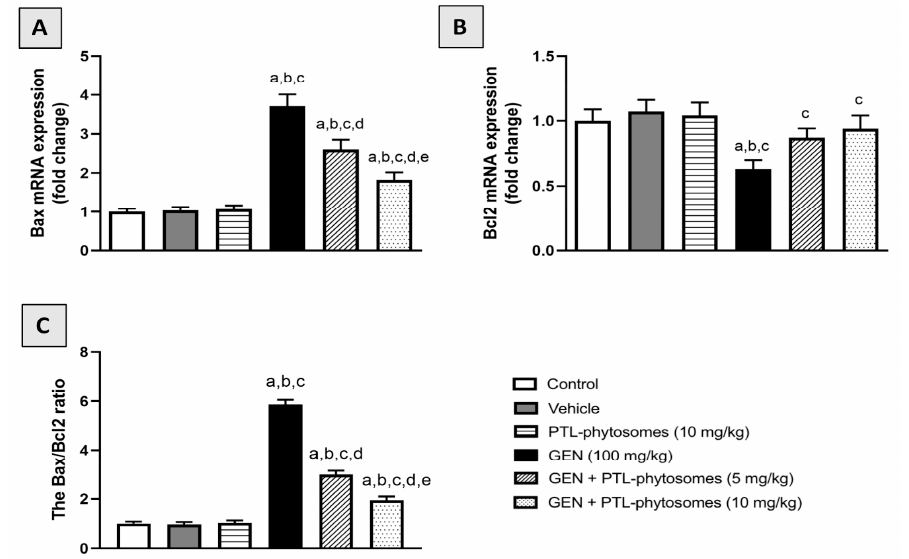
Figure 10. PTL-phytosomes regulated the expression of ( A ) Bax and ( B ) Bcl-2 ( C ) The Bax/Bcl-2 ratio in GEN-induced apoptosis. Data are expressed as Mean ± SD ( n = 6). a: significant when compared to control at p < 0.05; b: significant when compared to vehicle at p < 0.05; c: significant when compared to PTL-phytosomes at p < 0.05; d: significant when compared to GEN-alone at p < 0.05; e: significant when compared to GEN + PTL-phytosomes (5 mg/kg) at p < 0.05.